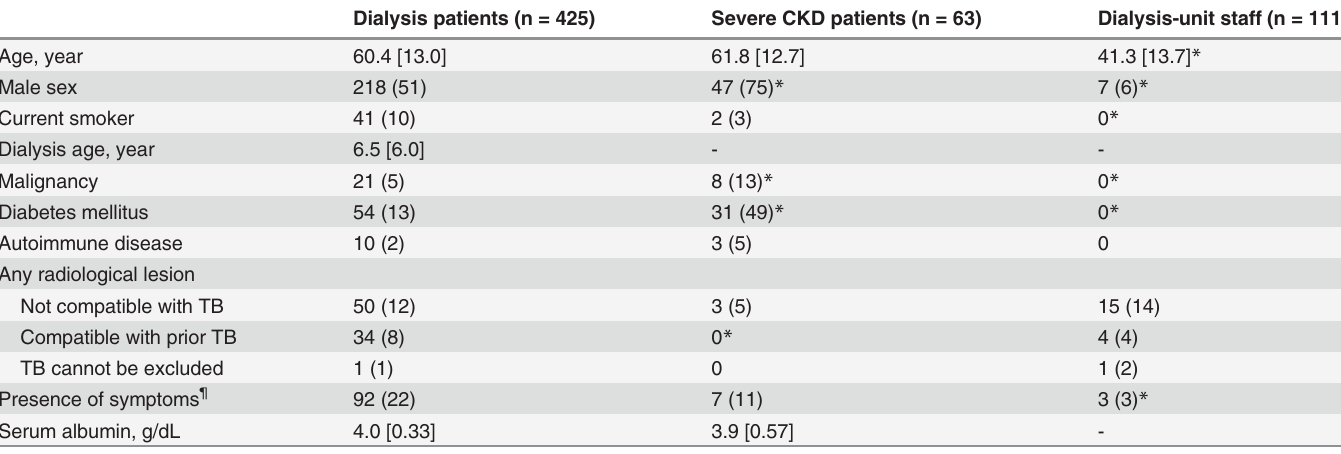
Table 1. Baseline clinical characteristics of the different study